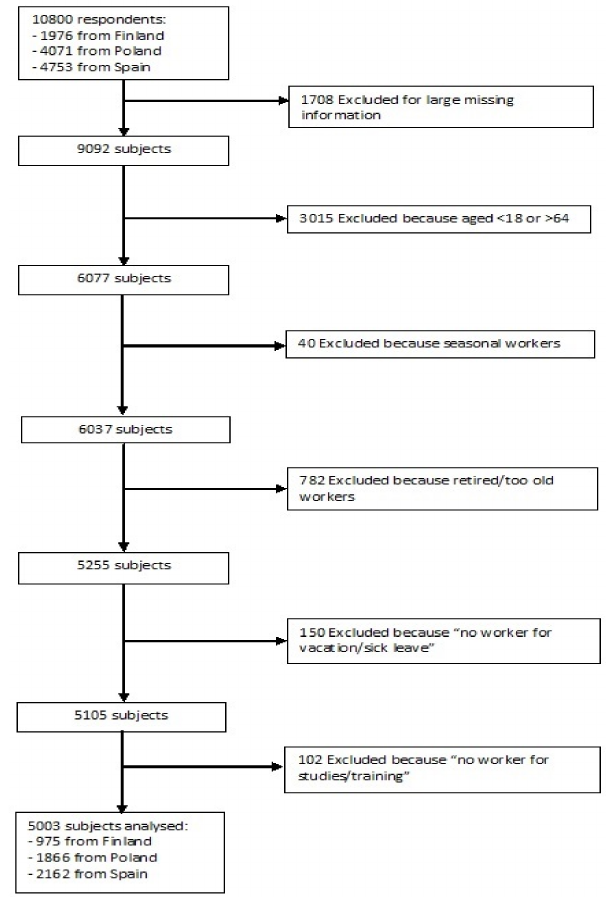
Figure 1. Flow diagram of the sample